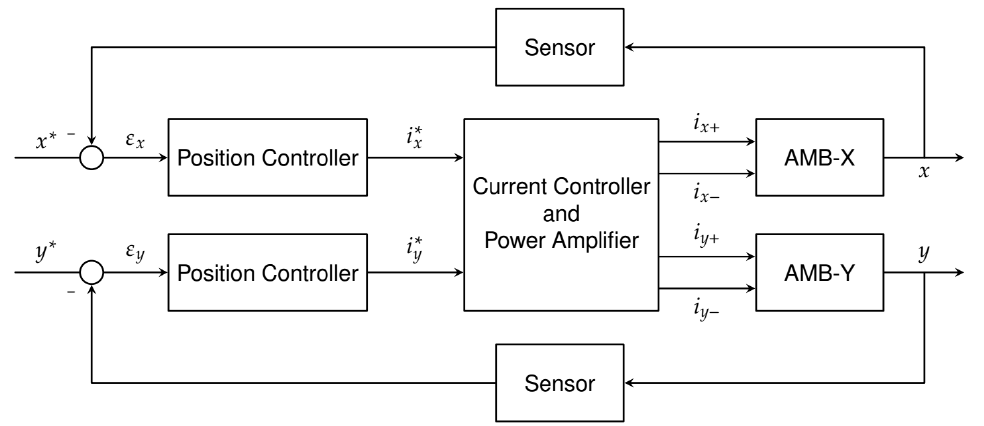
Figure 8. Block diagram of the simulated two-DOF